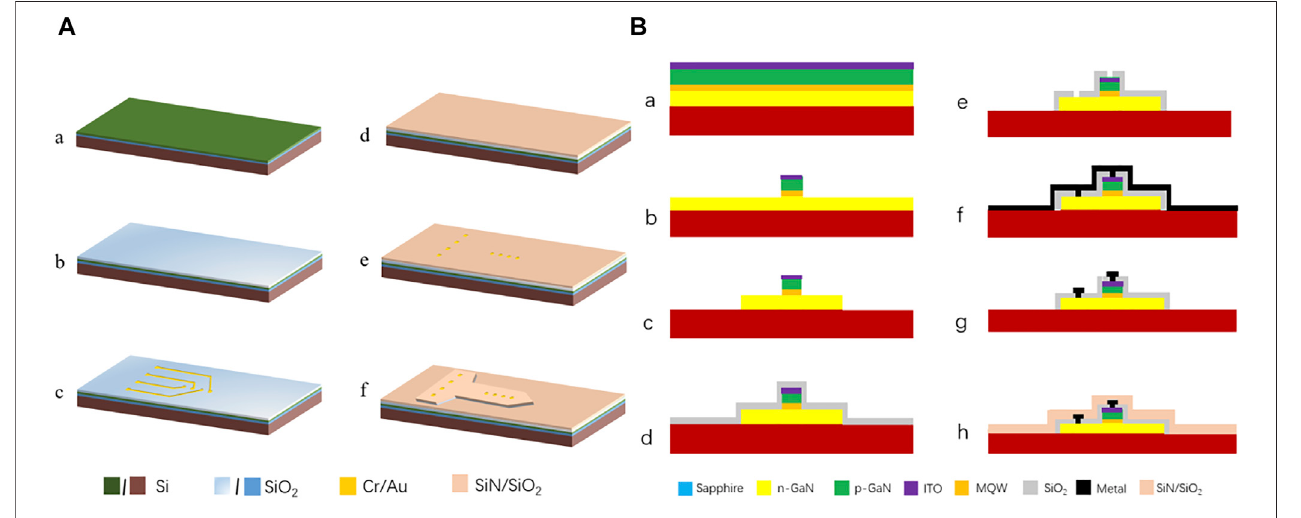
FIGURE 3 | Preparation process of (A) MEA and (B)